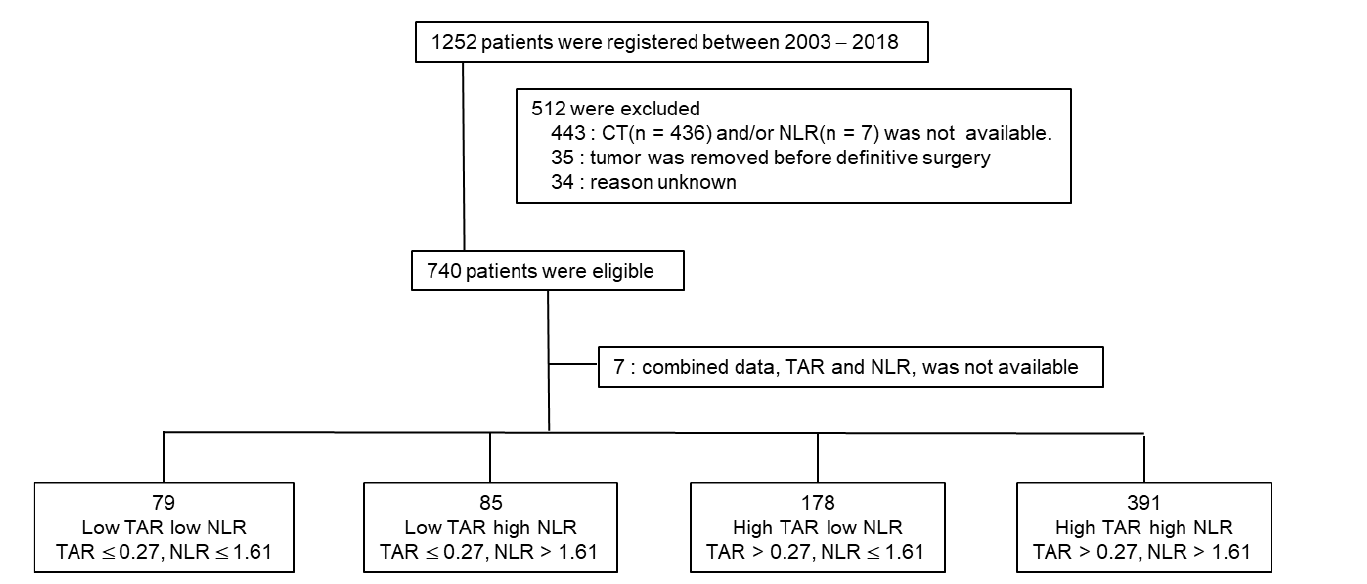
Figure 1. Study profile. A total of 1252 patients were diagnosed with primary breast cancer and completed their planned treatment between 2003 and 2018. Data of 740 patients were analyzed after excluding 512 patients who did not meet the eligibility criteria due to computed tomography (CT) not taken preoperatively ( n = 406), CT images were not archived ( n = 37), the tumor was removed before definitive surgery ( n = 35), and unknown reason ( n = 34). Among the 740 patients, 733 patients had both radiologic and serologic data to analyze the Hounsfield units of the tumor-to-aorta and neutrophil-to-lymphocyte ratios. Table 1. Clinicopathologic characteristics of the